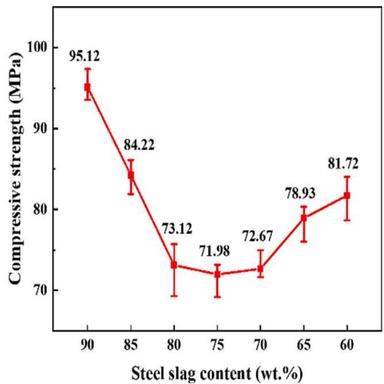
Compressive strength of samples after sintering at 1200 ◦C with different pretreated steel slag contents.